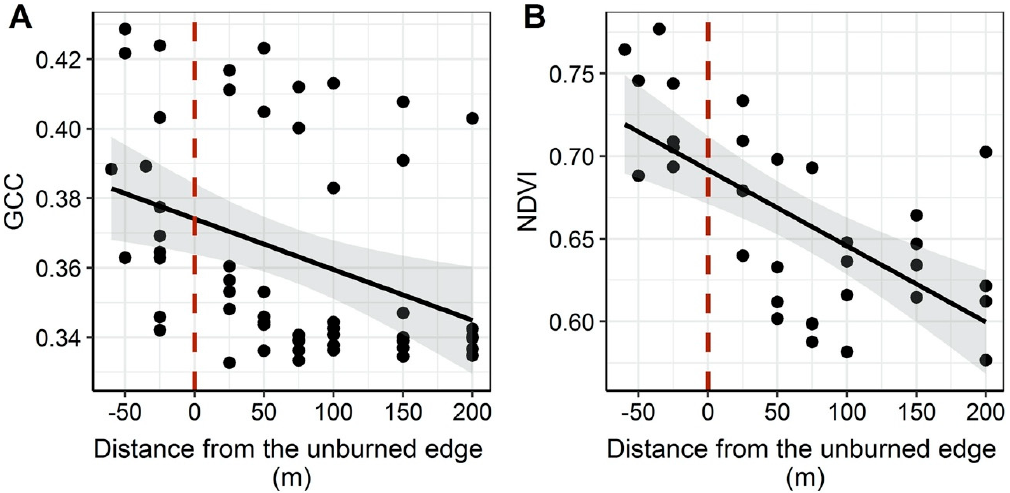
Figure 6. Linear models assessing the relationship between aggregated mean GCC ( A ) and NDVI ( B ) with a 10-m buffer radius and distance from the unburned edge into the fire perimeter. The zero dashed line indicates the edge of the fire perimeter. To the right of zero is the burned area and to the left is the unburned area. Both vegetation indices show a decline in values moving from the unburned into the burned. Panels show fitted relationship with 95% confidence intervals and raw data points. Raw data points show the variability in vegetation index values across the transects.